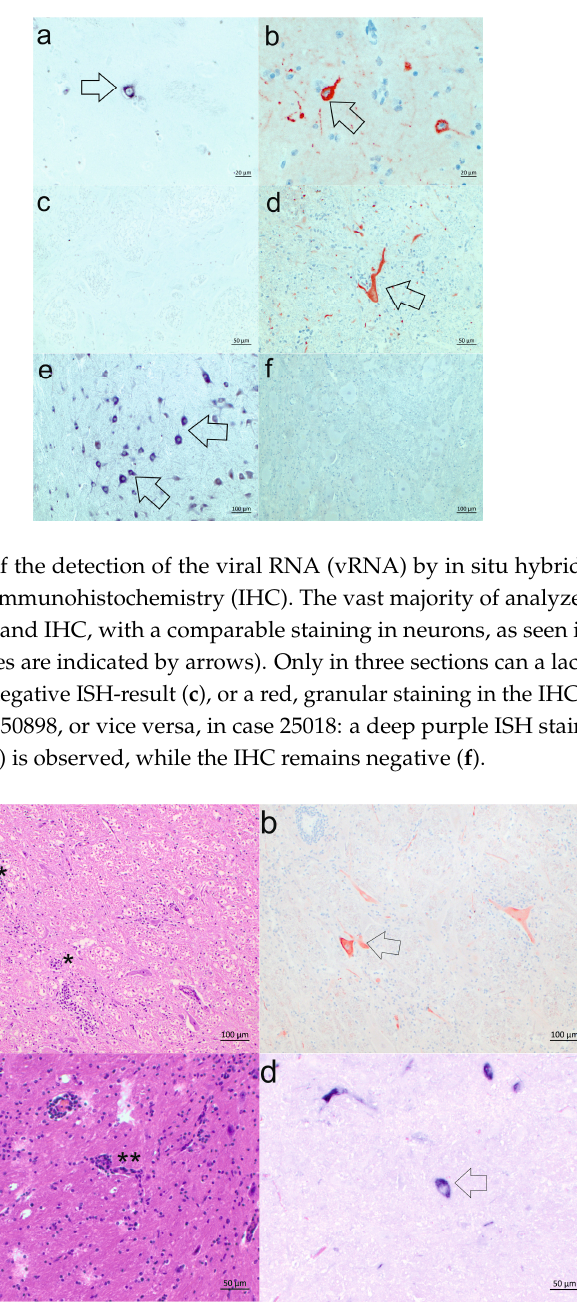
Figure 4. Correlation of pathological lesions and presence of the virus. Brainstem sections of two BoAstV CH13/NeuroS1-positive animals show glial nodes (*), neuronal necrosis (**), and perivascular cuffing (***) typical for non-suppurative bovine encephalitis in HE-stained sections. Severe lesions in the brainstem of case 50898 ( a ) show a good correlation to the results from the viral detection by IHC in most parts of the brainstem ( b , arrow). In the brainstem of case 26875 perivascular cuffs are observed ( c ), correlating well to the BoAstV CH13/NeuroS1 positive staining of neurons in ISH in the same area ( d , arrow).